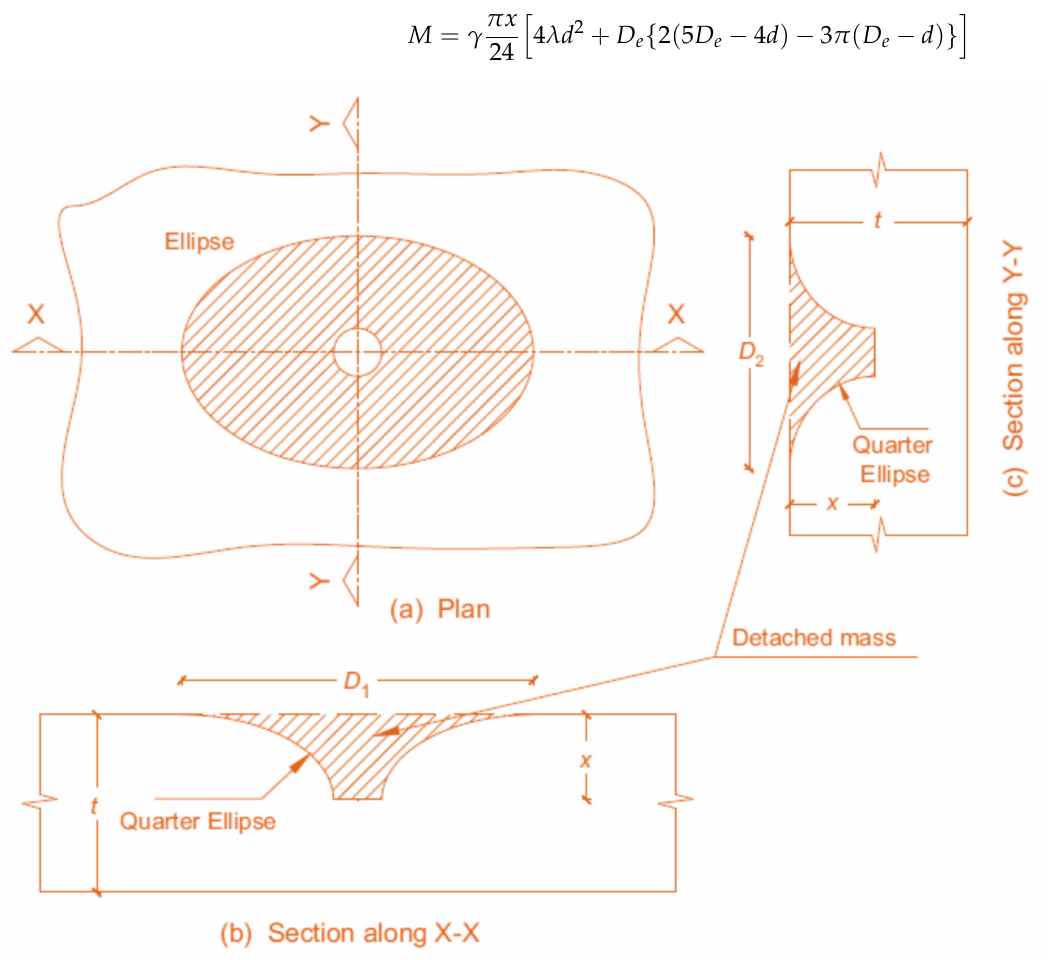
Figure 19. Schematic of top surface of the composite mass has been separated from its idealized state. (t = target depth; D 1 and D 2 are the crater’s major and minor diameters (measured on the top surface) and x = penetration depth).